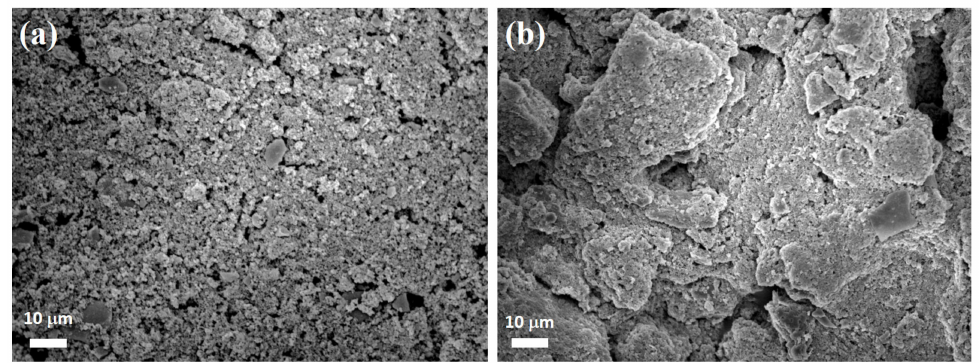
Figure 10. SEM images of Co/ZnO-NC electrodes before ( a ) and after cycling ( b ).